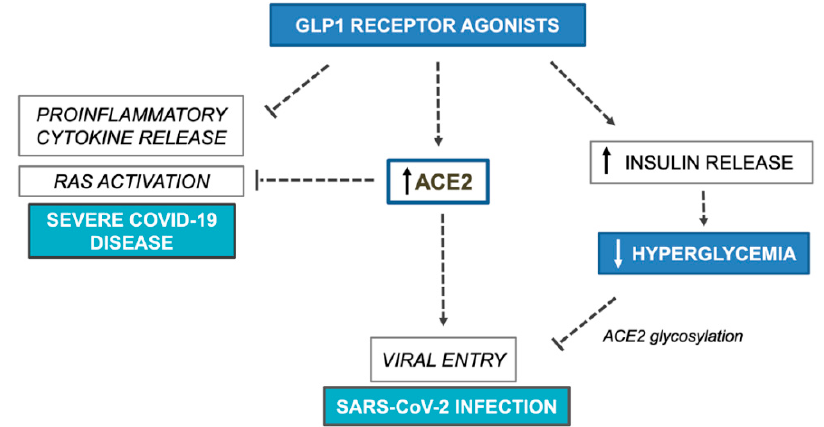
Figure 2. Potential benefits and harms of GLP1 receptor agonists on COVID-19 outcomes. GLP1, glucagon-like peptide 1; RAS, renin angiotensin system; ACE2, angiotensin converting enzyme 2; COVID-19, Coronavirus Disease 2019; SARS-CoV-2, Severe Acute Respiratory Syndrome Coronavirus 2.